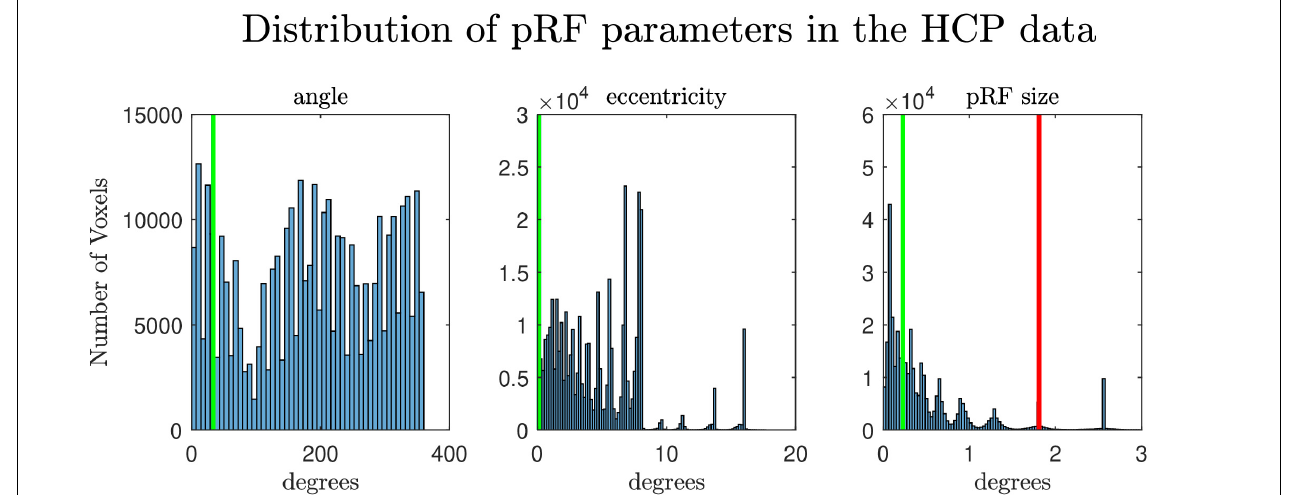
FIGURE 1 | Distribution of the estimated pRF parameters (angle, eccentricity and pRF size) from the retinotopy experiment of the HCP database (Benson et al., 2018). The vertical lines denote the values of the parameters of the pRF used in the second simulation. In the extreme right the green and the red lines denote the pRF sizes used for simulating the narrow and the broad pRFs respectively.